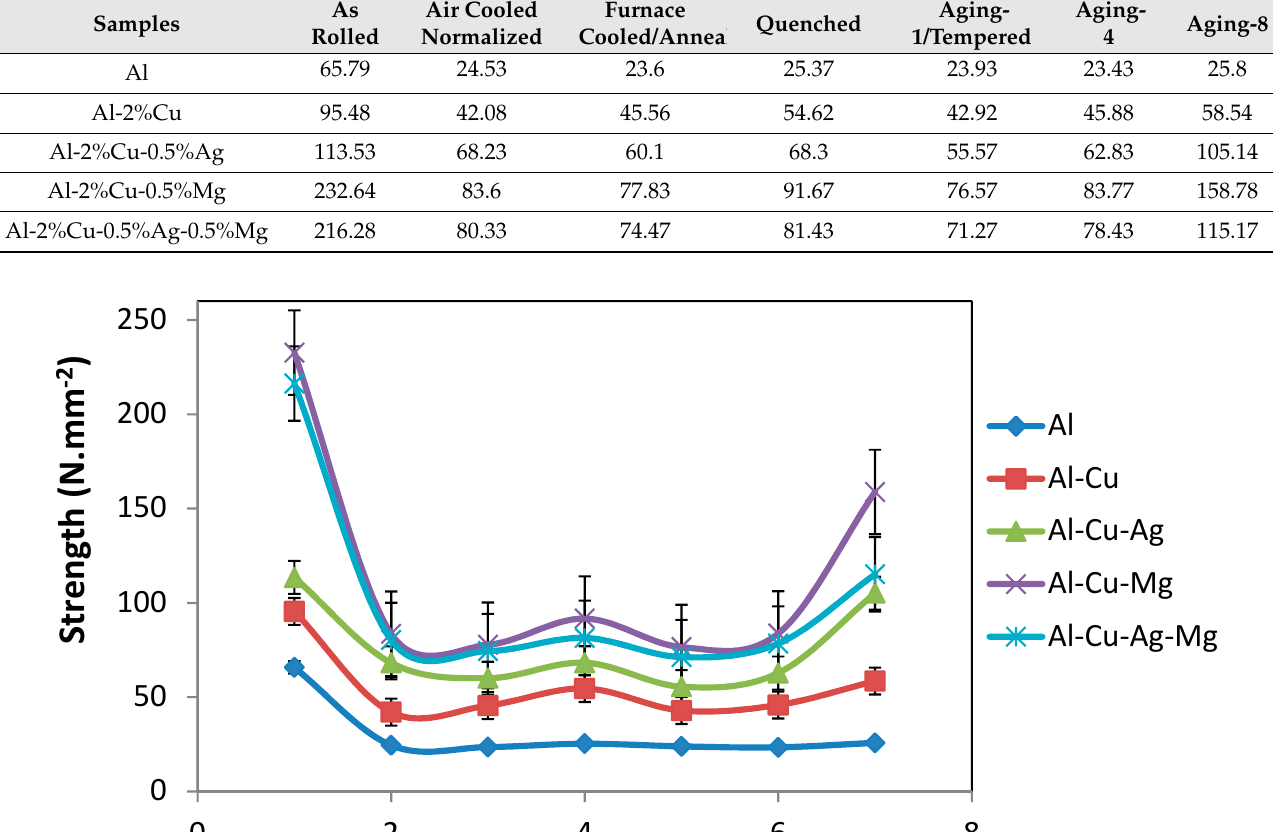
Figure 5. Stress–strain diagram of different alloys in age hardening conditions. Table 3. Yield Strength (N/mm 2 ) values of different heat-treated alloys. Table 3. Yield Strength (N/mm 2 ) values of different heat-treated alloys.